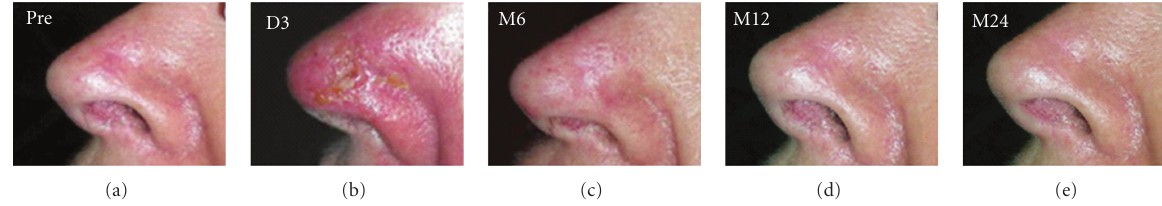
Figure 3: Treatment area pre-treatment (Pre), at day 3 (D3) and month 6 (M6), Month 12 (M12), and Month 24 (M24)